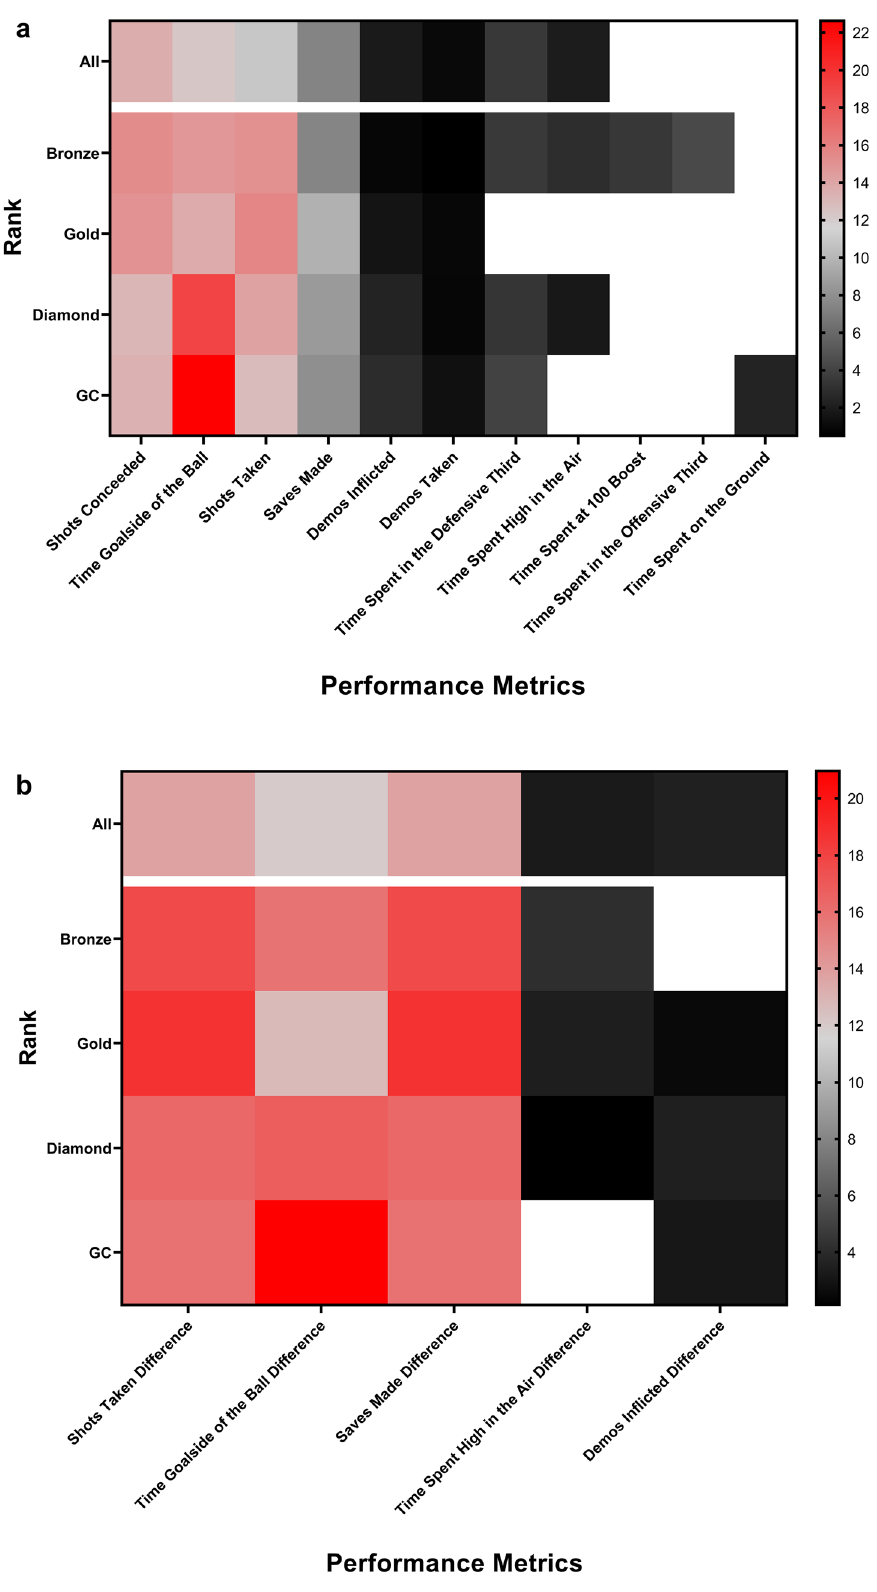
Figure 3. Heat map displaying the percentage of the total increase in MSE that can be found when a metric is permuted individually compared to the sum of increase in MSE for all metrics when permuted individually. Only metrics that were significantly important for predicting GD within each raw-score and difference-score model are presented. White squares represent metrics that were not significant for the rank they are assigned to. ( a ) Results from raw-score regression models, and ( b ) results from difference-score regression